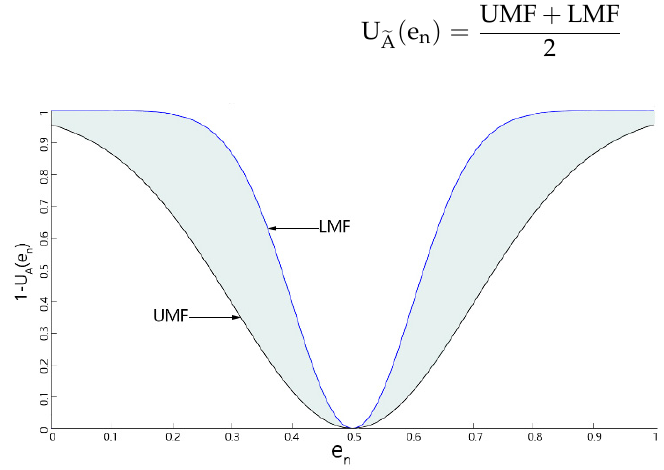
Figure 9. Membership function diagram.